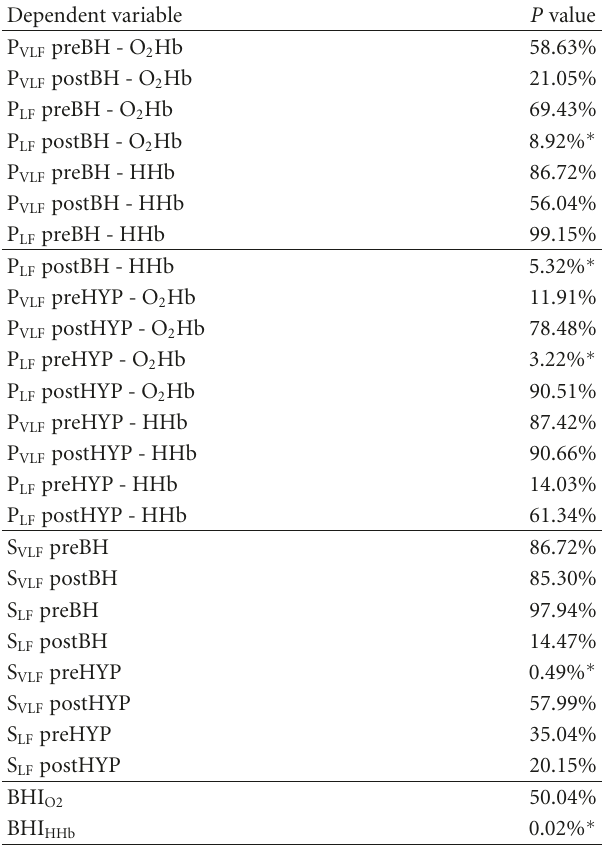
Table 1: ANOVA results. Results of one-way ANOVA analysis per- formed considering as independent variable the subject pathology (no migraine, MwA, or MwoA). The first column reports the dependent variables and the second column reports the associated P -value. The significant results ( P < 10%) are indicated with asterisk.